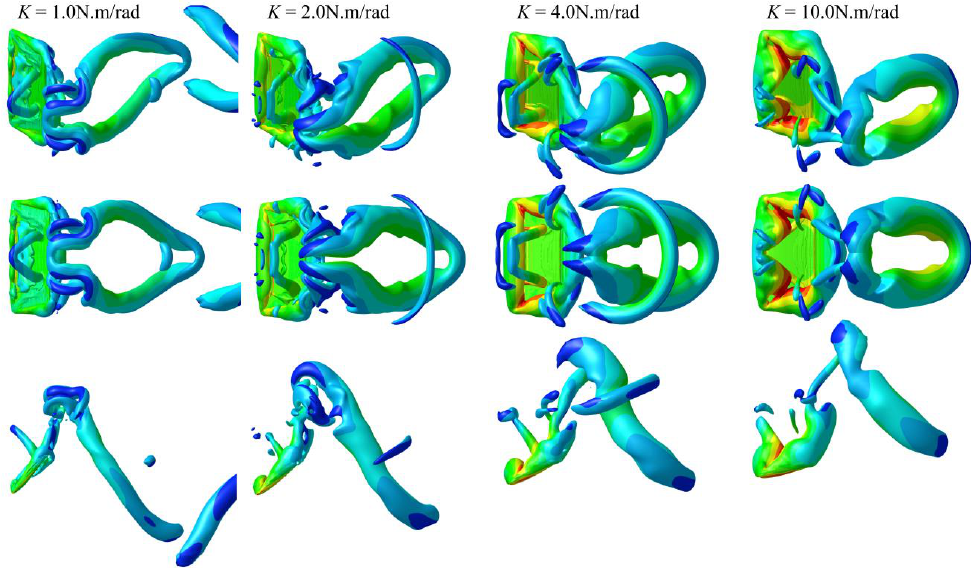
Figure 12. Flow condition of the flapping foil with different spring stiffness ( 𝐿/𝑐 = 5.0,𝐽 = 0.67 ).